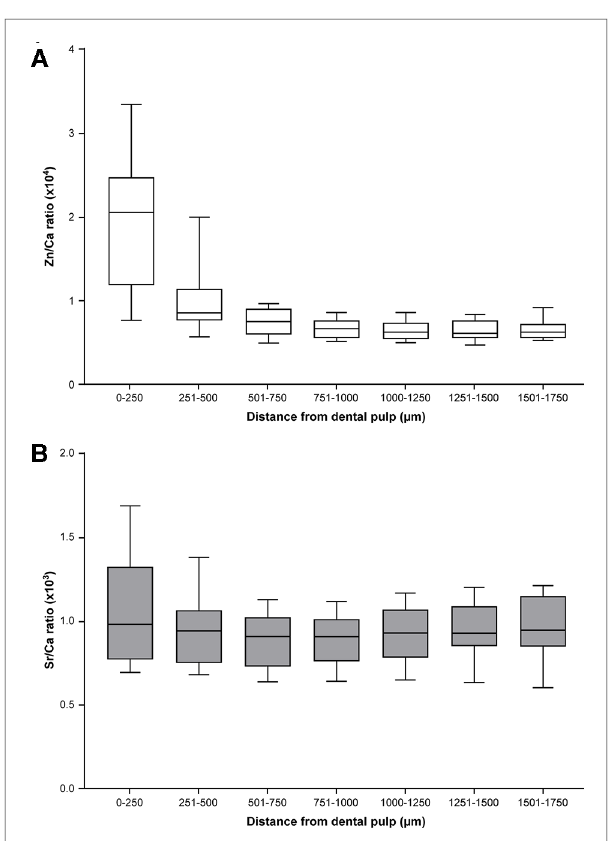
FIGURE 3 Distribution of Zn and Sr between the pulp and EDJ in deciduous teeth (median and 25th – 75th percentile with whiskers extending from smallest to largest value; n =18). ( A ) The Zn/Ca ratio differed in ablation pits according to the distance from the pulp to the EDJ (Friedman test, p <0.0001). The ratio was signi fi cantly higher in ablation pits closest to the pulp [a,b p <0.05, c,d p <0.01 (Dunn ’ s post-hoc test)]. ( B ) The Sr/Ca ratio in ablation pits also differed according to distance from the pulp to the EDJ (Friedman test, p < 0.0001) and was signi fi cantly lower in ablation pits in the region 501